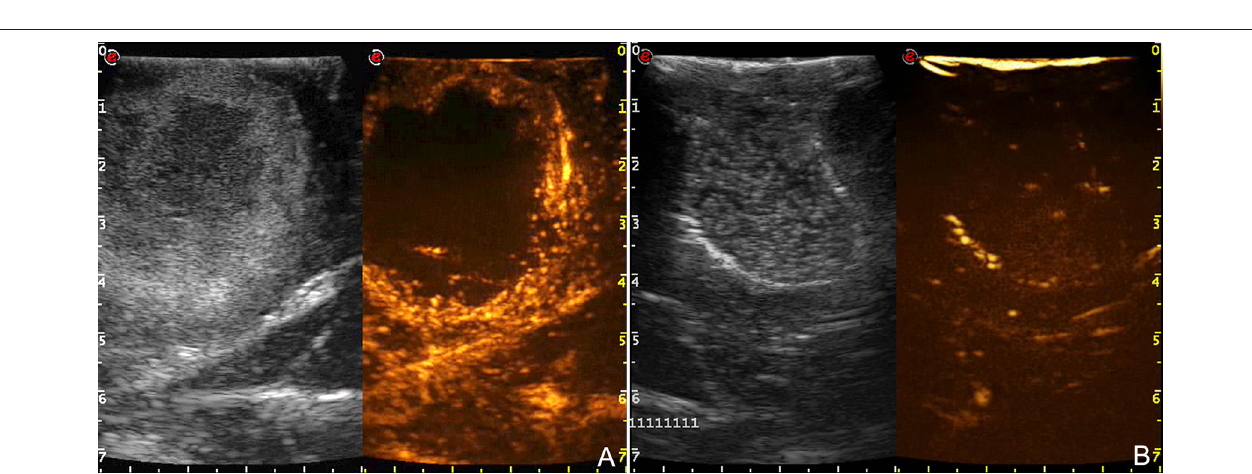
FIGURE 7 | Time-frame of contrast enhancement in a case of right temporal glioblastoma. GBM have a rapid arterial and venous phase. MBs transit is chaotic and the peak is extremely intense. The major arterial supplies and draining veins are clearly visible. Contrast enhancement pattern is irregular and heterogeneous CE with both nodular high-enhanced and hypoperfused areas. Tumor borders are better defined than in B-mode.